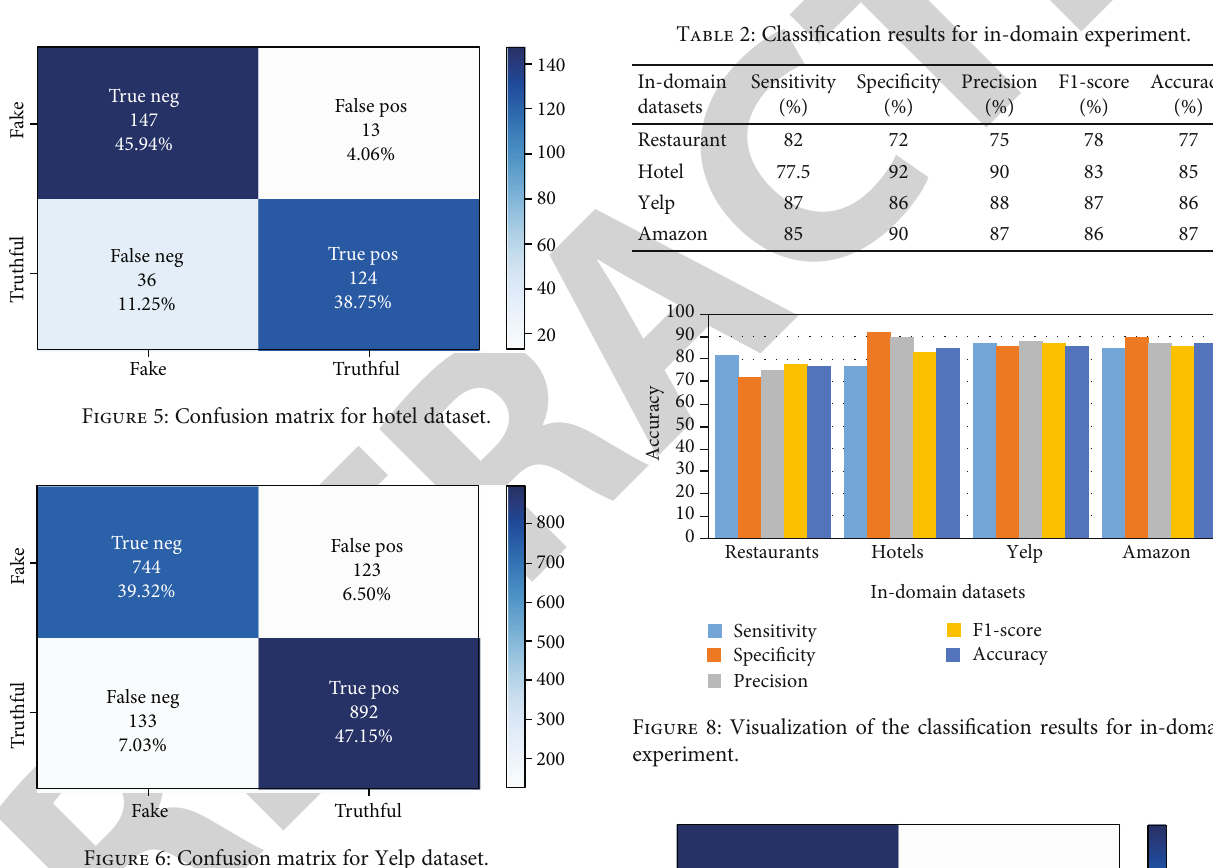
Figure 6: Confusion matrix for Yelp dataset.